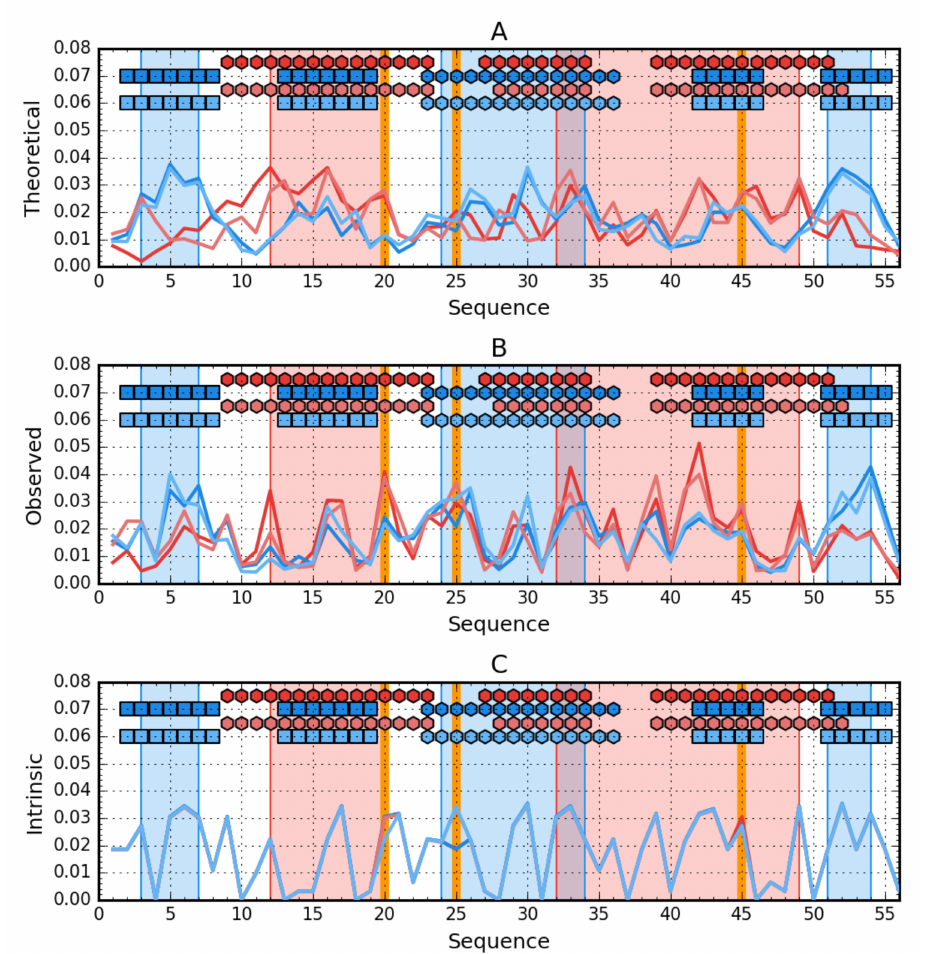
Figure 6. Hydrophobicity density comparison between Ga98 (red), Gb98 (blue), Gb98-T25I (bright red) and Gb98-T25I, L20A (bright blue). ( A ) theoretical ( T ) distributions; ( B ) observed; ( O ) distributions; ( C ) intrinsic (H) distributions. Markers at the top of each subplot denote elements of the secondary structure: Hexagons—alpha helices, squares— β -strands (Ga98 & Gb98-T25Y—Red, Gb98 & Gb98-T25I, L20A—Blue). Blue-shaded regions encompass contiguous sequence fragments containing hydrophobic core in Gb98 and Gb98-T25I, L20A. The cores in Ga98 and Gb98-T25I are shaded red. Mutations (L20A, T25I, L45Y) are shown as vertical orange